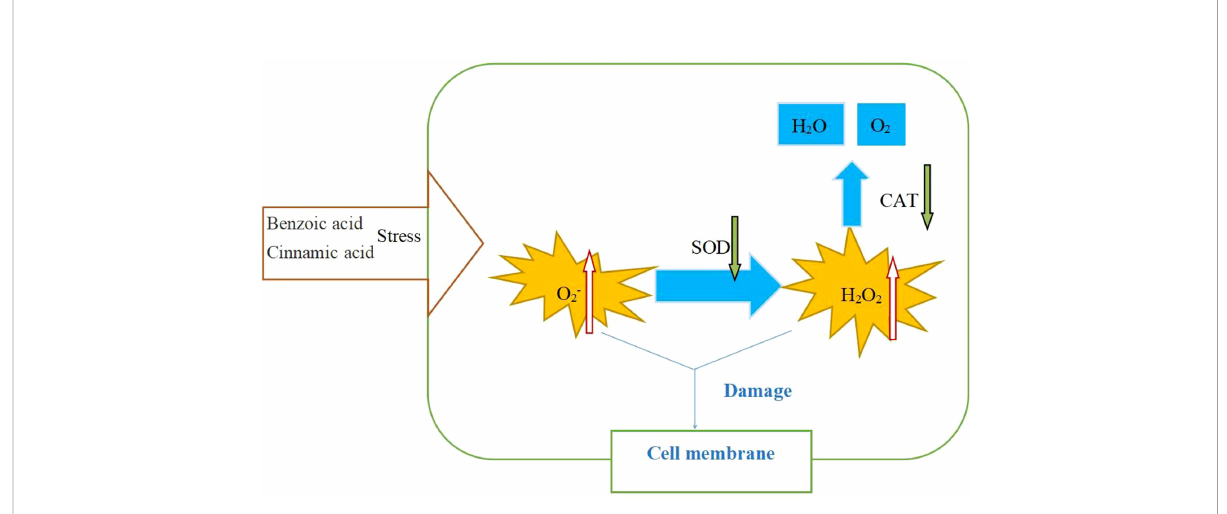
FIGURE 6 Effects of benzoic acid and cinnamic acid on physiological and biochemical processes of faba bean ( Vicia faba